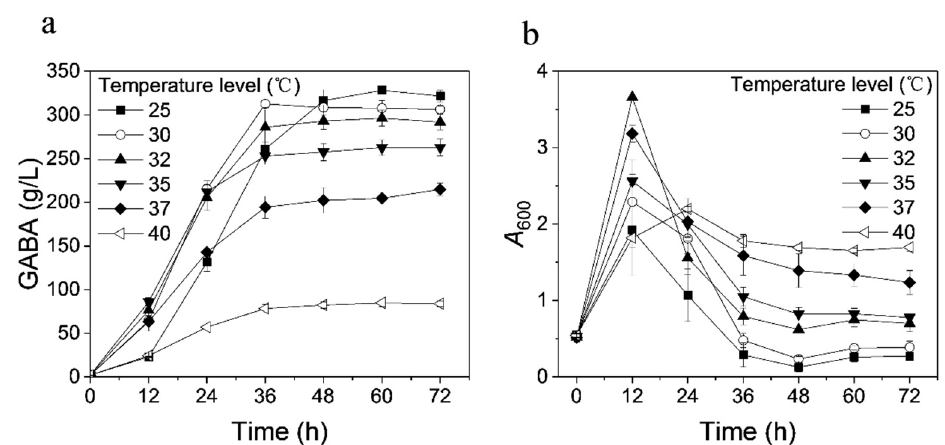
Figure 5. The effect of fermentation temperature on ( a ) GABA production and ( b ) cell growth. This was evaluated using a 250 mL Erlenmeyer fermentation flask. Cell growth was expressed as A 600 . Vertical bars represent standard deviations of means ( n = 3). There was no significant difference in 48 h GABA concentration between 25 °C and 30 °C ( p = 0.926) or 32 °C ( p = 0.136), but there was a significant difference between 25 °C and 35 °C ( p = 0.000), 37 °C ( p = 0.000), or 40 °C ( p = 0.000). GABA, gamma-aminobutyric acid; A 600 , absorbance at 600 nm.